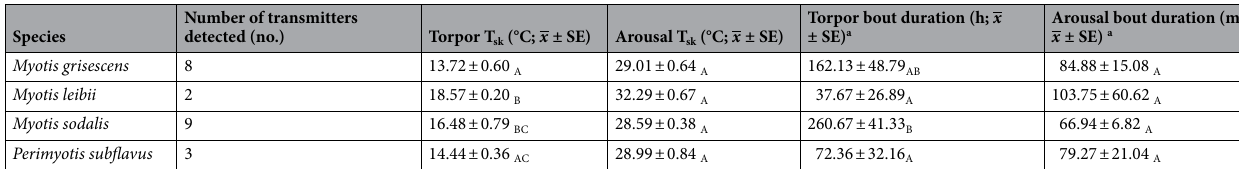
Table 1. The number of transmitters detected, mean skin temperature (T sk ) during torpor and arousal, and mean torpor (hours) and arousal (minutes) bout durations of four bat species tracked with temperature- sensitive radio transmitters at four cave hibernacula in Tennessee during hibernation (November 1–March 31) of 2016–2019. a x ± SE in the same column followed by the same uppercase letter are not significantly different ( P >